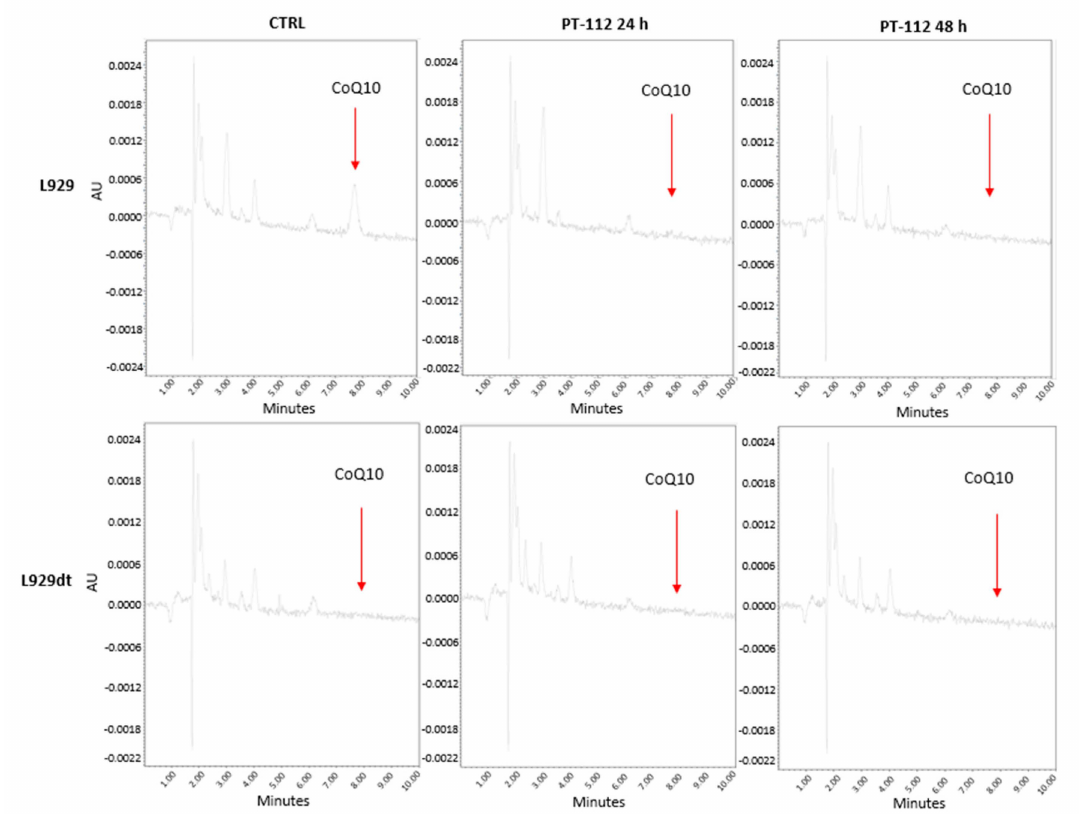
Figure 9. HLPC determination of mitochondrial CoQ10 amounts on L929 or L929dt cells after treatment with PT-112. The mitochondrial lipid fraction of 20 × 10 6 cells (L929 or L929dt), treated with 10 µ M PT-112 for 24 or 48 h was extracted. Untreated cells (CTRL) were also included. CoQ10 levels were determined by HPLC methodology (see Materials and Methods). Commercial CoQ10 was used as a positive control (see Figure S2). Representative plots are